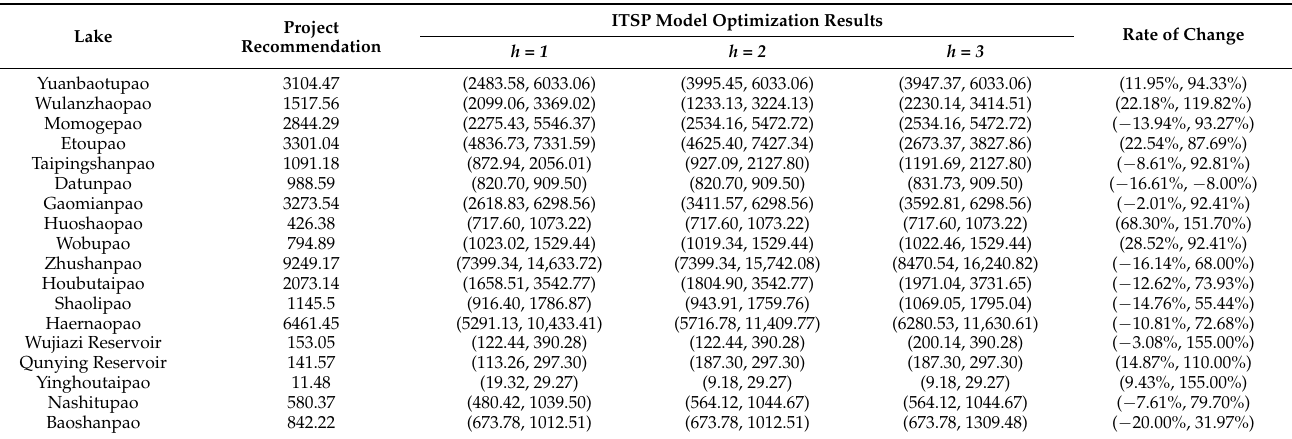
Table 3. NSC in each lake in JMNNR (10 4